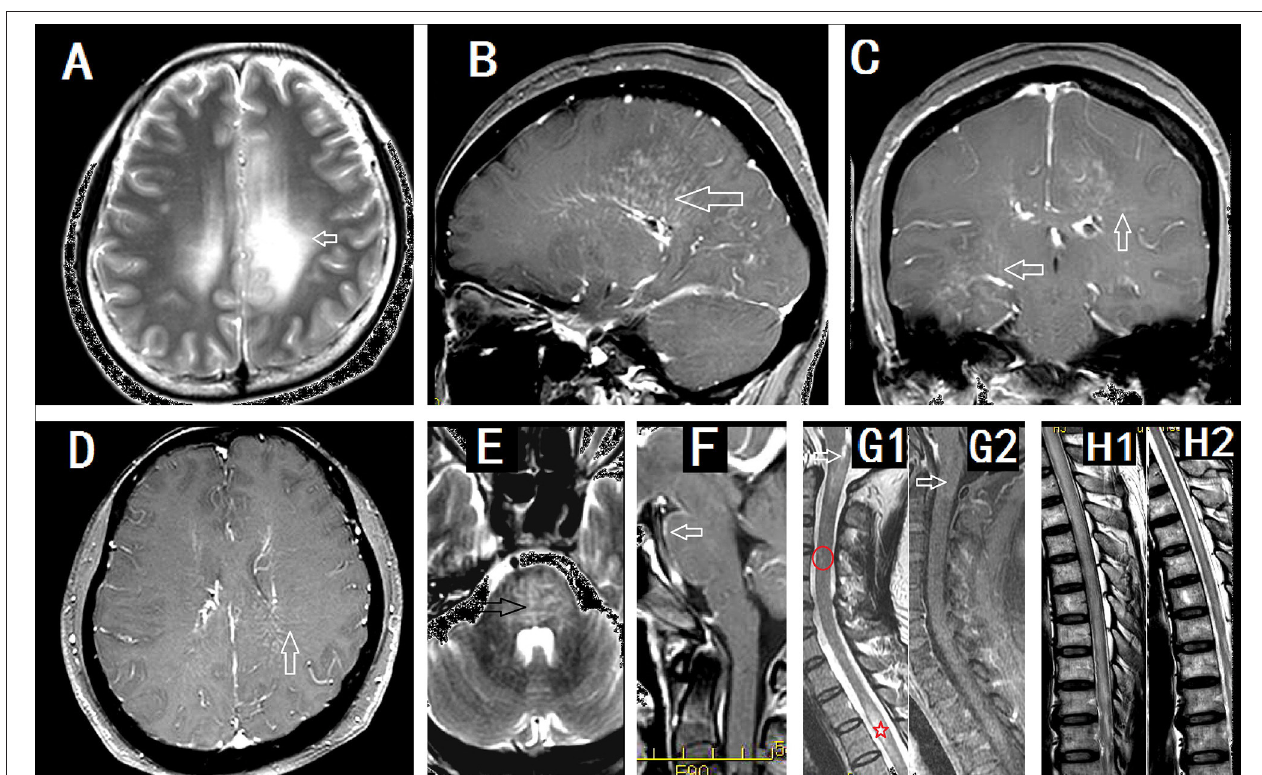
FIGURE 2 | Imaging findings in patients with GFAP astrocytopathy. (A–D) were from a female meningoencephalitis patient. (A) MR images showing extensive abnormalities in the white matter around the ventricle (arrow). (B) Sagittal section showed linear perivascular radial gadolinium enhancement in the white matter perpendicular to the ventricle(arrow). (C,D) Coronal section (C) and cross section (D) showed vessel-like enhancement (arrows). (E) and (F) from a male meningoencephalitis patient showed pons abnormality (black arrow) and pia enhancement (white arrow). (G1) and (G2) were from a female with myelitis. (G1) Cervical lesion extended to the area postrema of medulla(arrow), sparse cervical abnormality(red round area) and thoracic LESCLs (star marker). (G2) Slightly enhancement in medulla (arrow). (H1) and (H2) were from a male meningoencephalomyelitis patient. Longitudinal extensive lesions in the whole spinal cord (H1) and soon recovery after the treatment (H2)